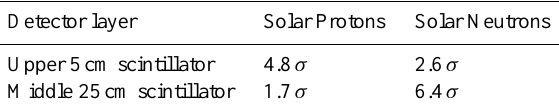
Table 6. Simulated enhancements (in standard deviations) of the “5-min” count rates corresponding to GLEs initiated by primary neutrons (1) and primary protons (2).